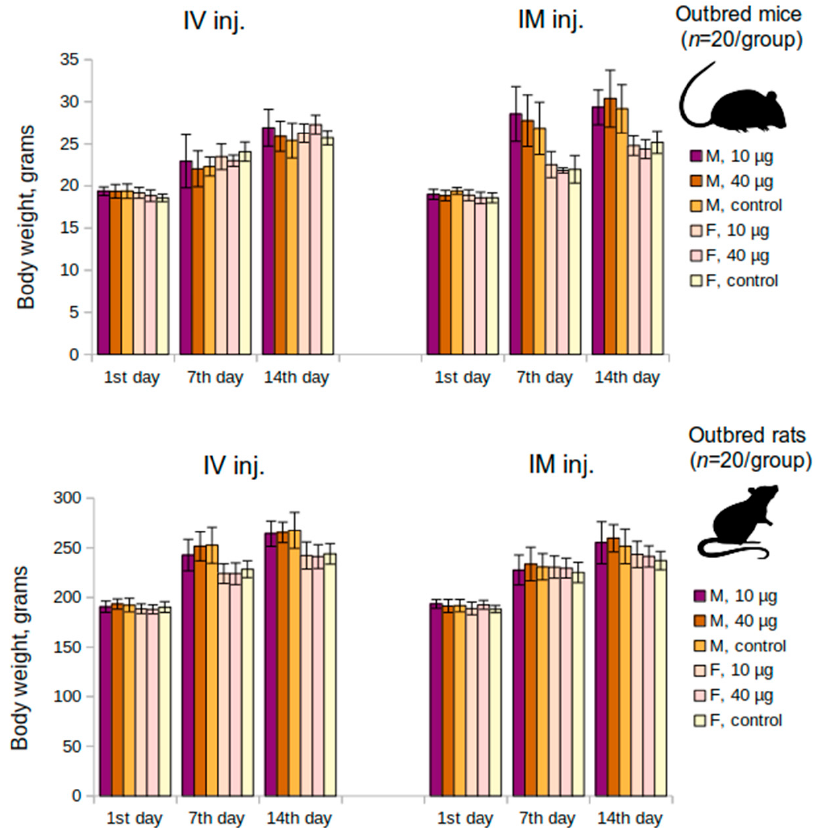
Figure 1. Mean changes of body weight over time in the acute toxicity study in mice and rats groups. M—males, F—females, IM inj.—intramuscular injection, IV inj.—intravenous injection; p >